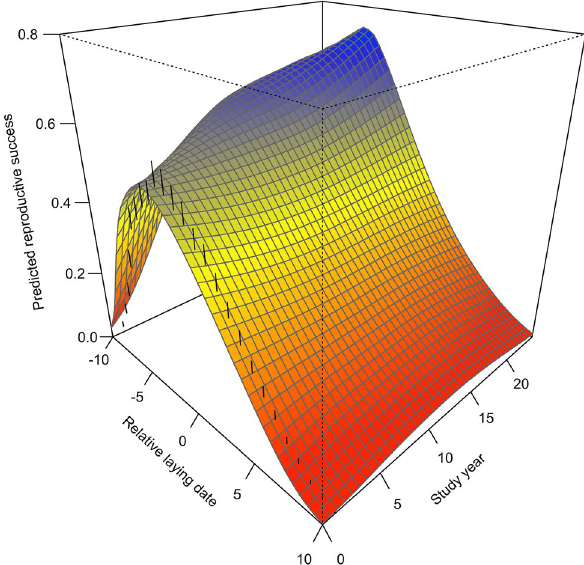
Figure 1. Predicted reproductive success of greater snow geese for each study year and relative laying date (from Day − 10 to + 10) from 1991 to 2015. Reproductive success is the number of offspring reaching 1 year of age. Day 0 is the annual median laying date of the population. Study year is a continuous variable, where 1991 is year 0. The surface represents the interpolation of reproductive success values for each relative day across study years. Blue indicates the highest values in the component, and red the lowest values. Confidence intervals at 95% (black vertical lines on left of surface) for each relative laying date are presented for year 0 (1991) and are similar across years. See also contour plot in Supplementary Fig.